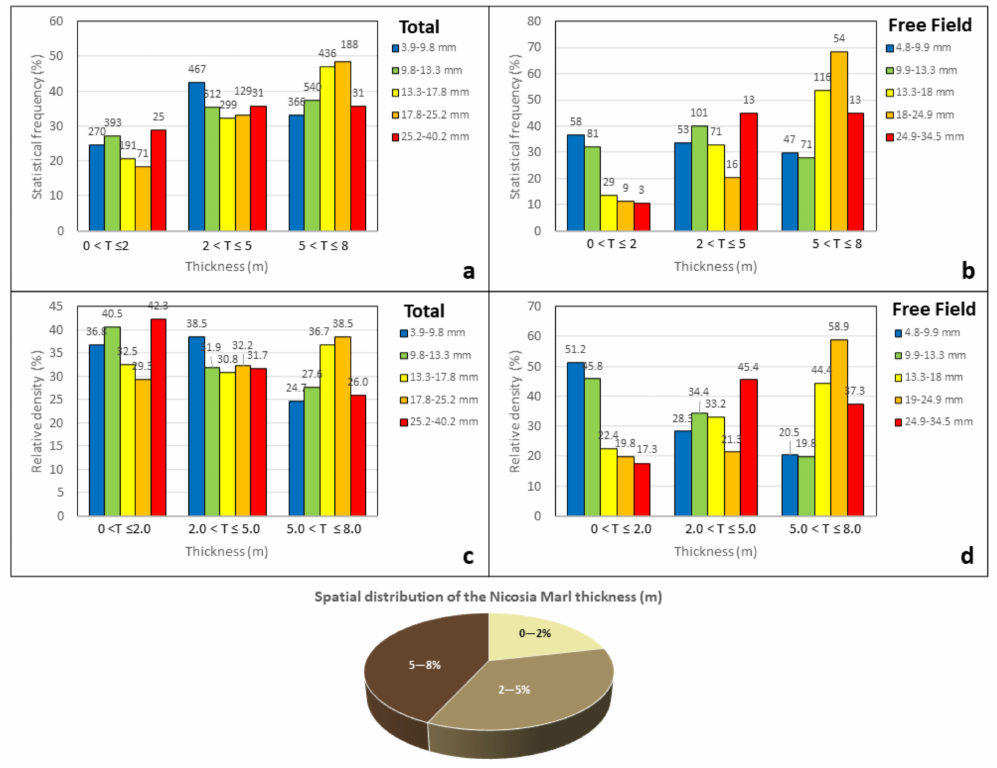
Figure 12. Statistical frequency ( a , b ) and relative density ( c , d ) of the vertical displacement amplitude points as a function of the khaki marl thickness for total and free field PS